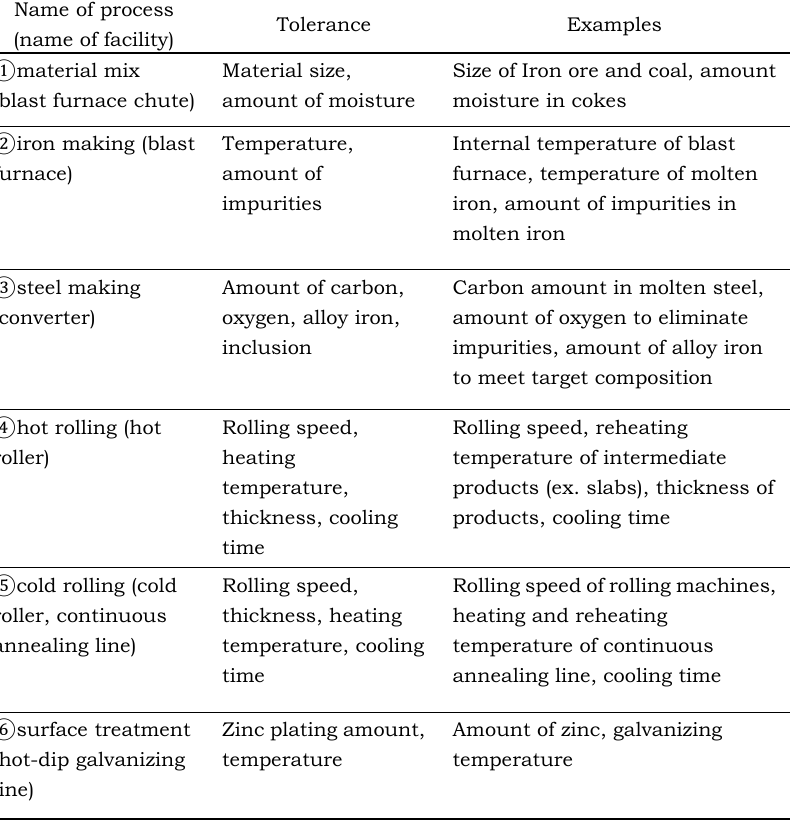
Table 1. Examples of tolerance setting in steel manufacturing